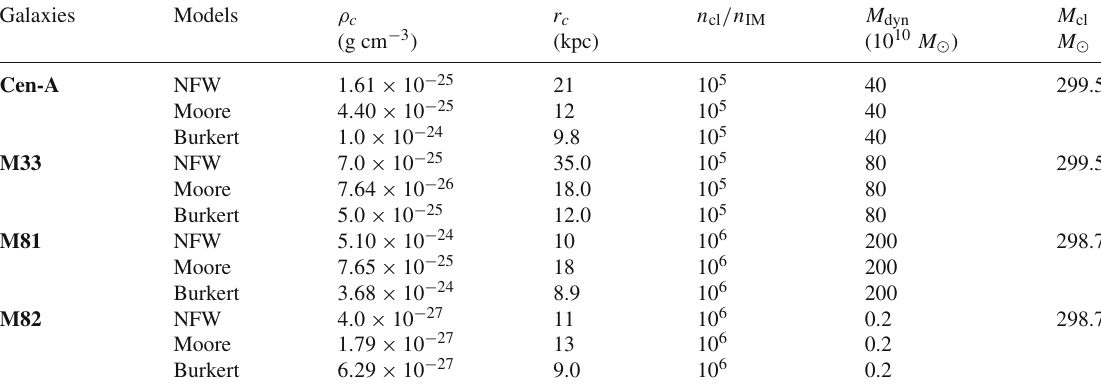
Table 1 Physical parameters of the considered nearby spiral galaxies Galaxies